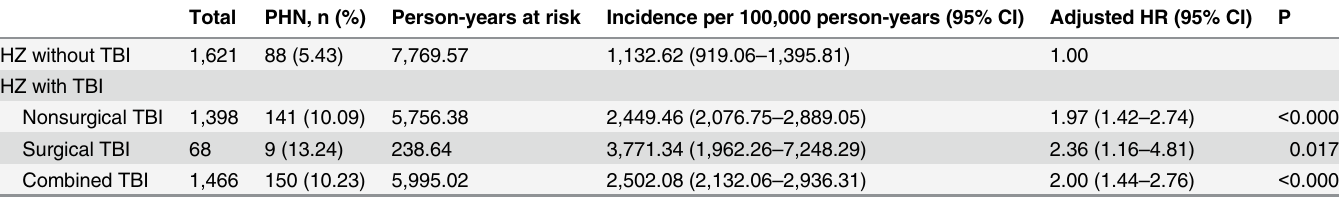
Table 3. Incidence and hazard ratios for post-herpetic neuralgia during the follow-up period for adult patients with traumatic brain injury among herpes zoster patients.